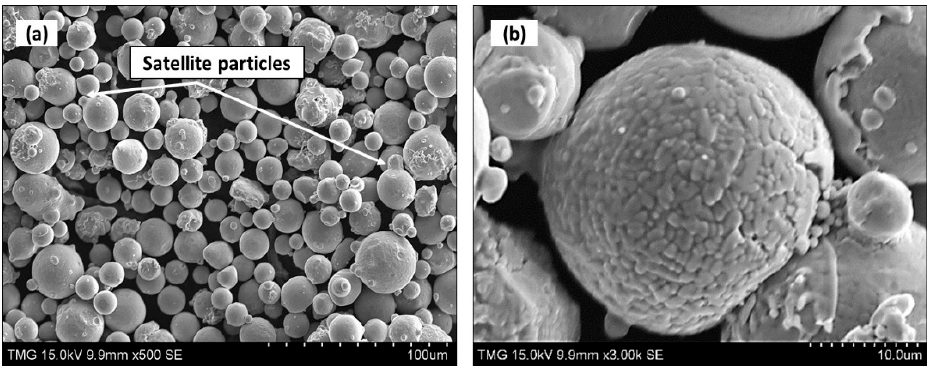
Figure 1. ( a, b ) Secondary electron scanning electron microscopy (SEM) micrograph of Inconel 718 (IN718) powder. Table 1. Nominal chemical composition of gas atomized IN718 powder.